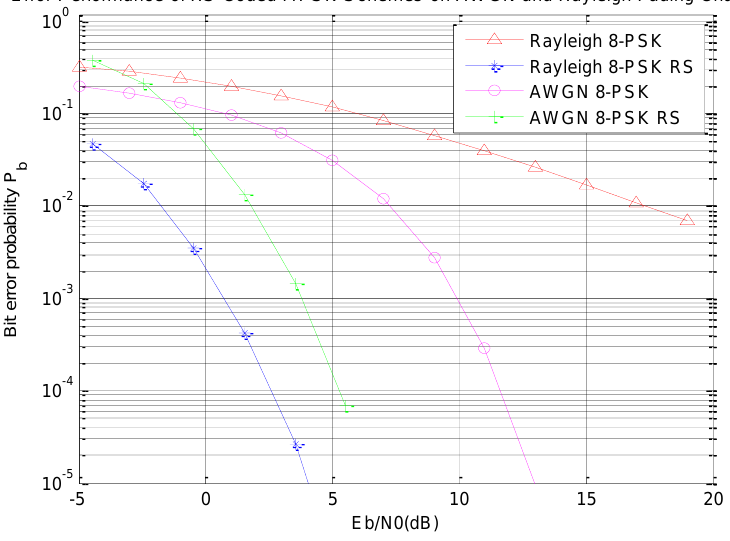
Figure 4. Error performance of RS coded MPSK